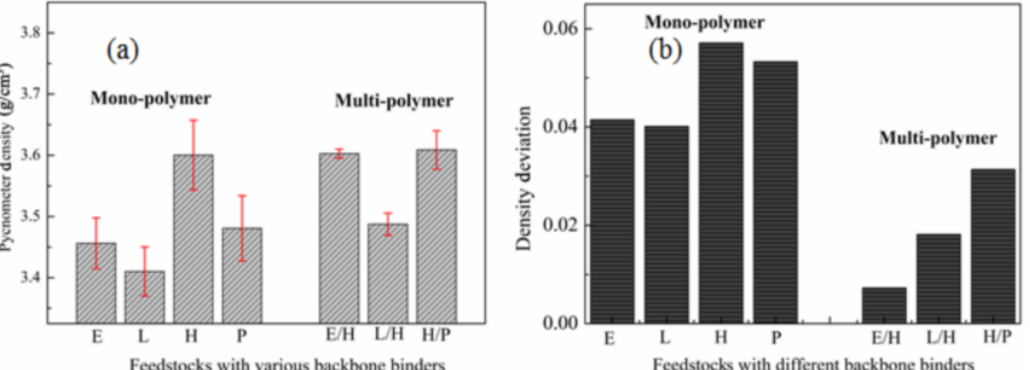
Fig. 3 (a) Pycnometric density of feedstocks with various thermal polymers; (b) deviation of density with different thermal polymers.